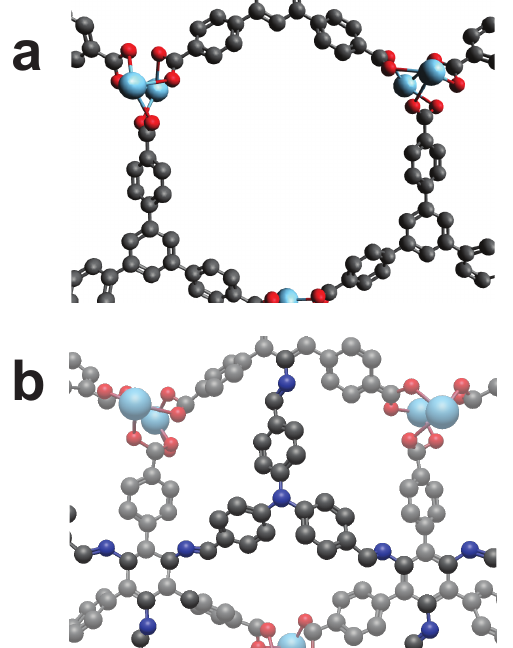
Figure 7. The MOF “RUYVEO” can be cross-linked by using the cross-linker CL3. ( a ): Unmodified view of RUYVEO. ( b ): Cross-linked RUYVEO. Color code: as above plus Lanthanung (Turquoise). Hydrogens omitted for